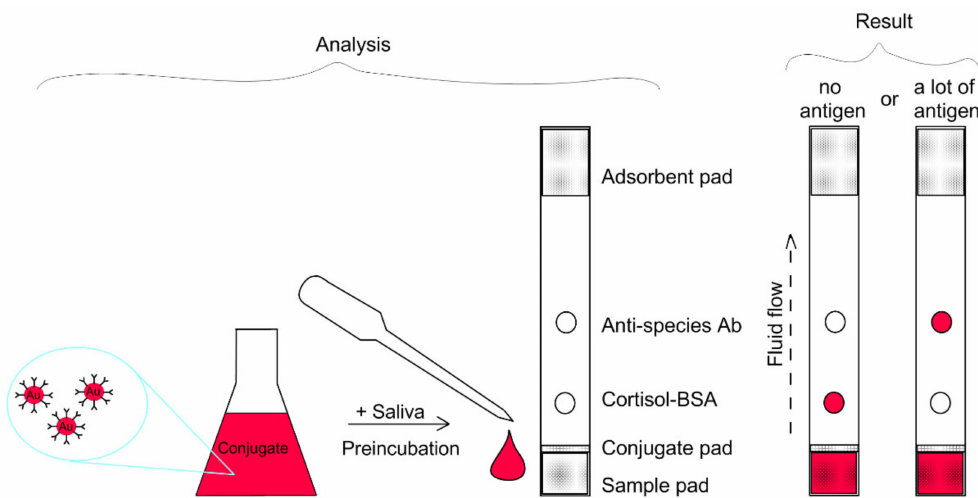
Figure 1. Scheme of immunochromatographic analysis in a competitive format. On the ( left ), the analysis procedure is shown, which includes preincubation of the sample with the conjugate, as well as the scheme for applying the reagents to the test strip. On the ( right ), two extreme cases for the analysis result are shown: the absence of antigens in the sample, and a large quantity of